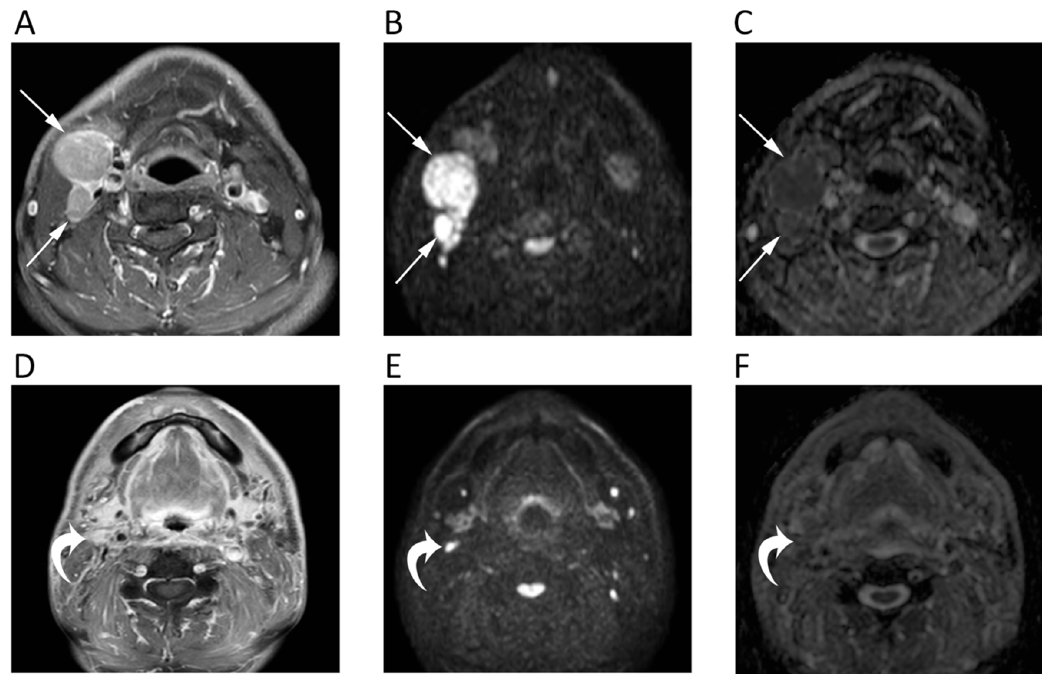
Figure 2. MRI scans of a 65-year-old male patient with oropharyngeal squamous cell carcinoma and lymph nodal metastases. Contrast-enhanced T1w ( A ), high b -value DWI ( B ), and corresponding ADC map ( C ) before chemotherapy show round enlarged right cervical lymph nodes (arrows) with restricted pattern of di ff usion (mean ADC: 0.891 × 10 − 3 mm 2 / s). The same images after treatment ( D – F ) show the good response to chemotherapy with normal size and unrestricted pattern of di ff usion of the cervical lymph nodes (curved arrows).